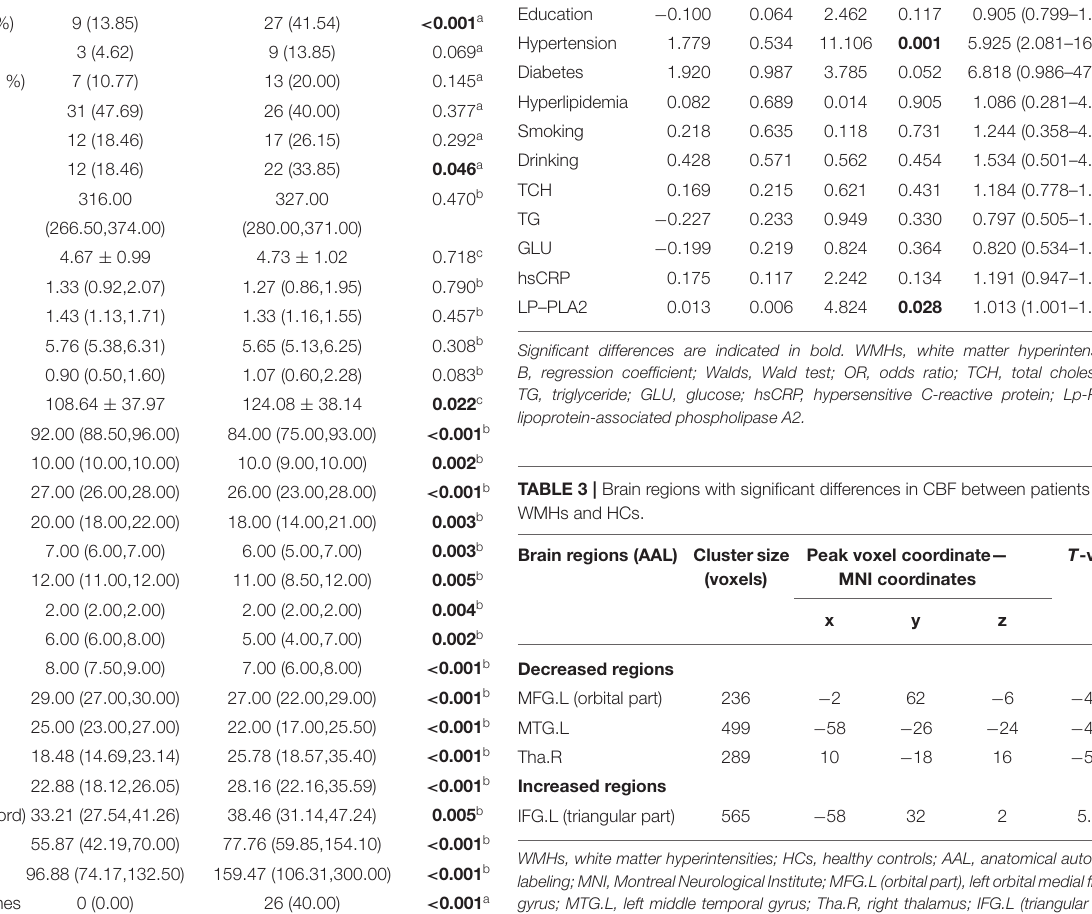
WMHs, white matter hyperintensities; HCs, healthy controls; AAL, anatomical automatic labeling;MNI,MontrealNeurologicalInstitute;MFG.L(orbitalpart),leftorbitalmedialfrontal gyrus; MTG.L, left middle temporal gyrus; Tha.R, right thalamus; IFG.L (triangular part), left triangular inferior frontal